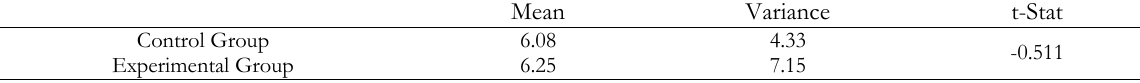
Table 2. Comparative pretest performance of the groups